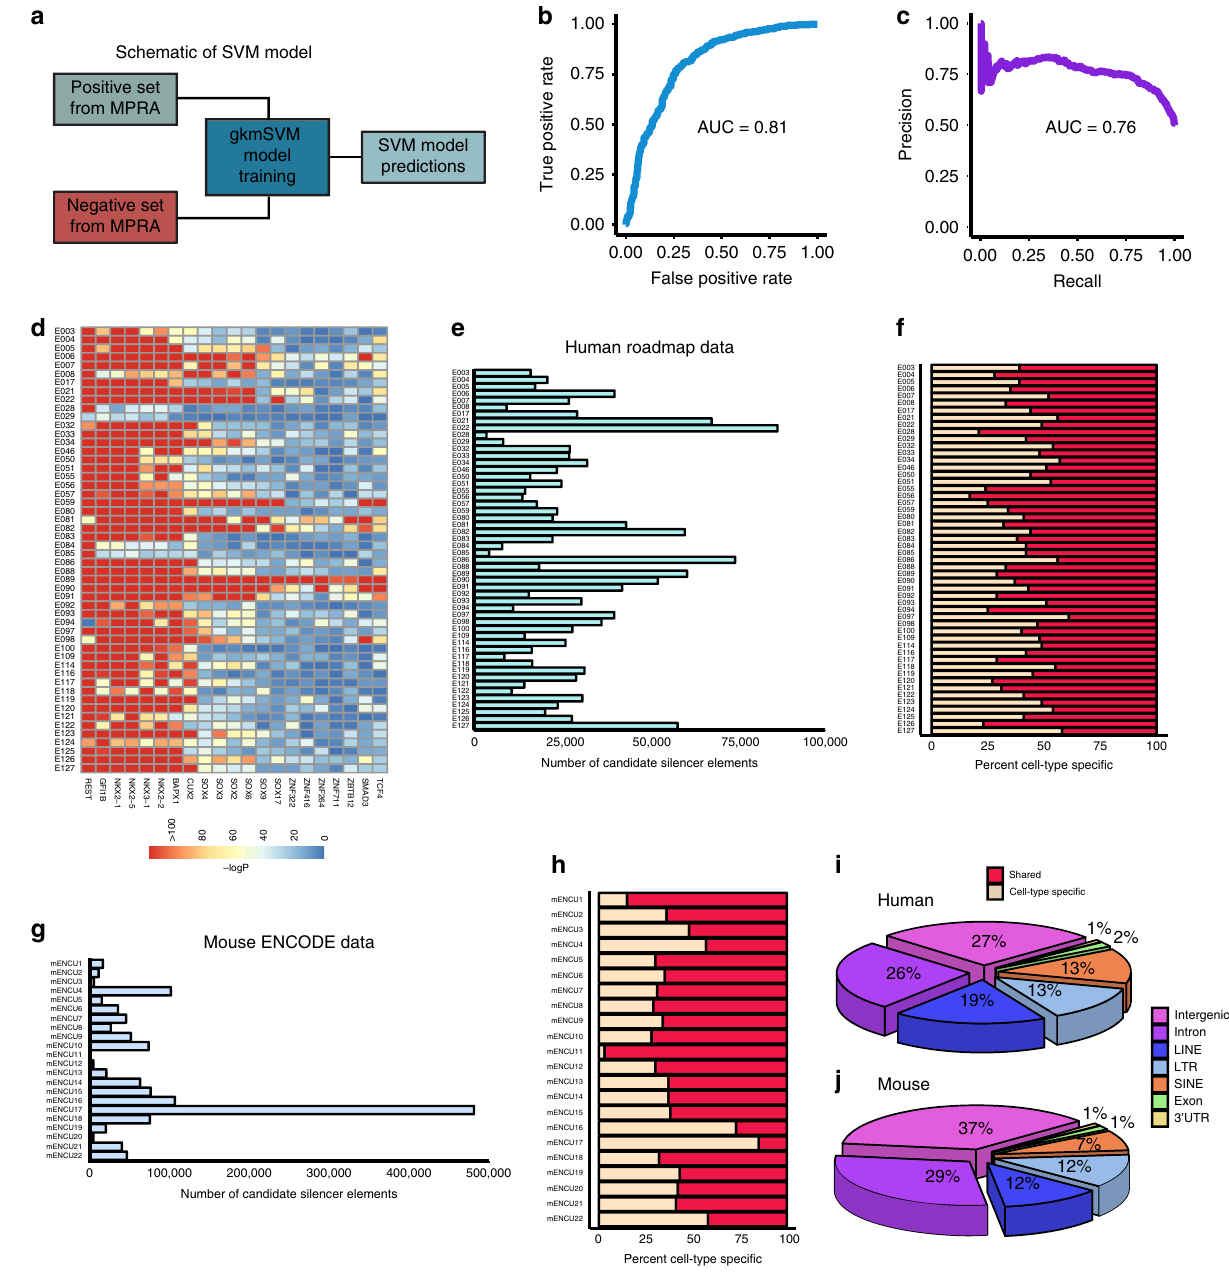
Fig. 3 Overview of SVM model and candidate silencer element predictions. a Schematic overview of the gkmSVM model development for candidate silencer predictions. The trained gkmSVM model performance on test data shown by receiver operating characteristic (ROC) curve ( b ) and precision recall curve ( c ). d Heatmap of enrichment (-log( P -value)) of TF motifs at SVM positively predicted uncharacterized CREs (candidate silencers) relative to SVM negatively predicted uncharacterized CREs across 52 cell types and tissues from Roadmap. Barplots presenting the count of predicted candidate silencer elements across different cell types and tissues in human from Roadmap ( e ) and mouse genomes from ENCODE ( g ). Distribution of cell-type-speci fi c candidate silencer elements in human ( f ) and mouse genomes ( h ). Pie chart showing the genomic distributions of candidate silencer elements in human ( i ) and mouse ( j